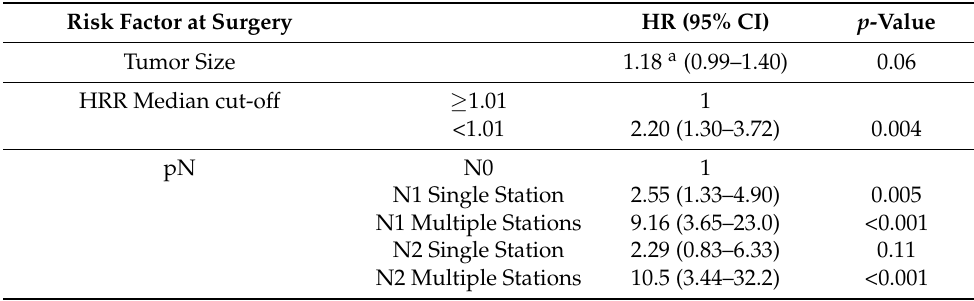
Table 3. Disease-free survival multivariable analysis treatment-adjusted.